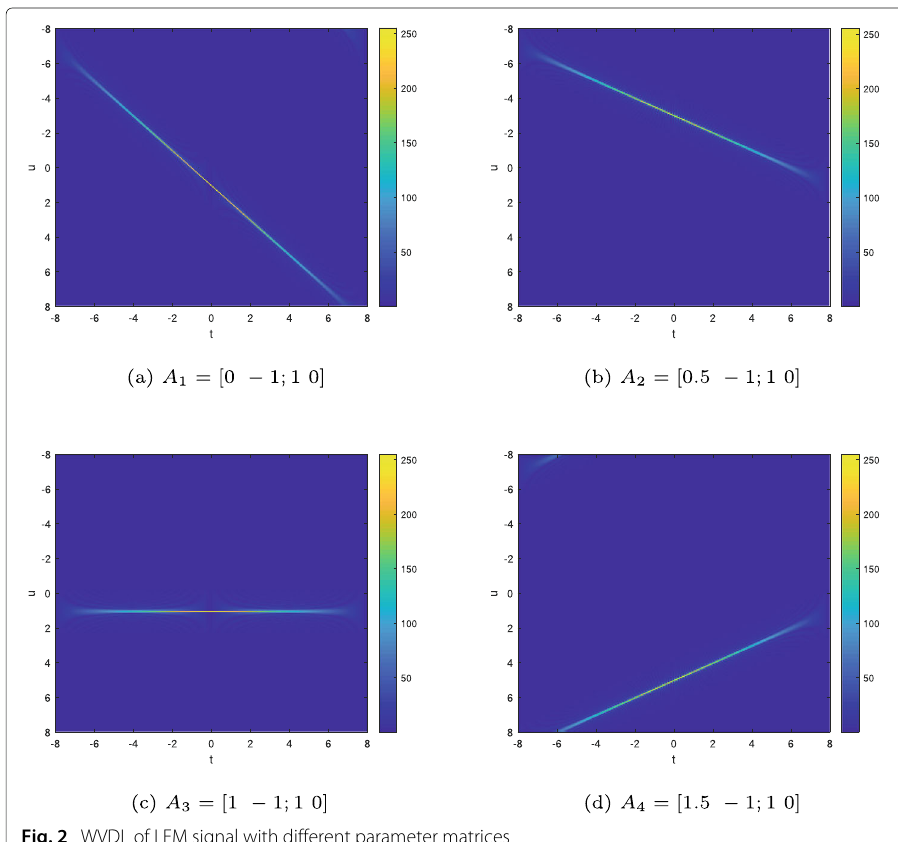
Fig. 2 WVDL of LFM signal with different parameter